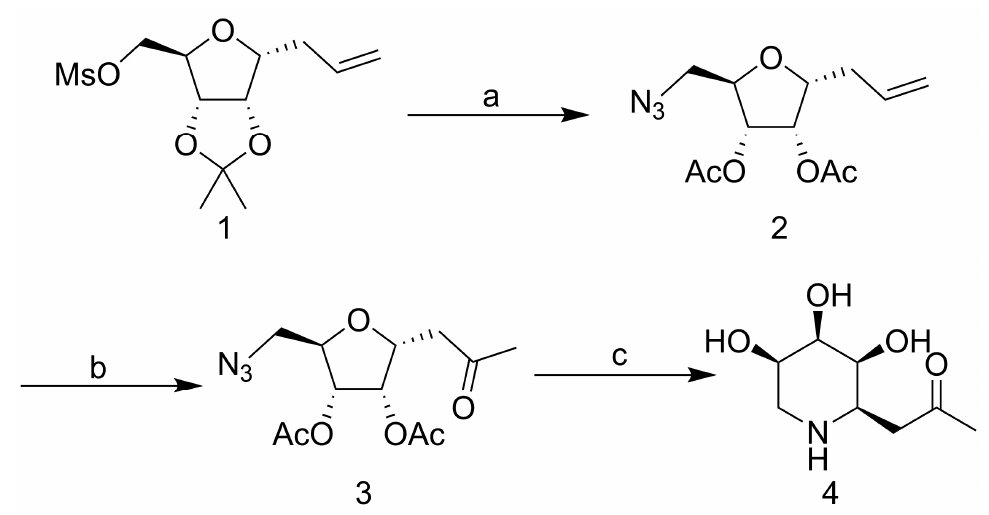
Table 1. Screening of synthesis conditions of N ‐ substituted iminosugar C ‐